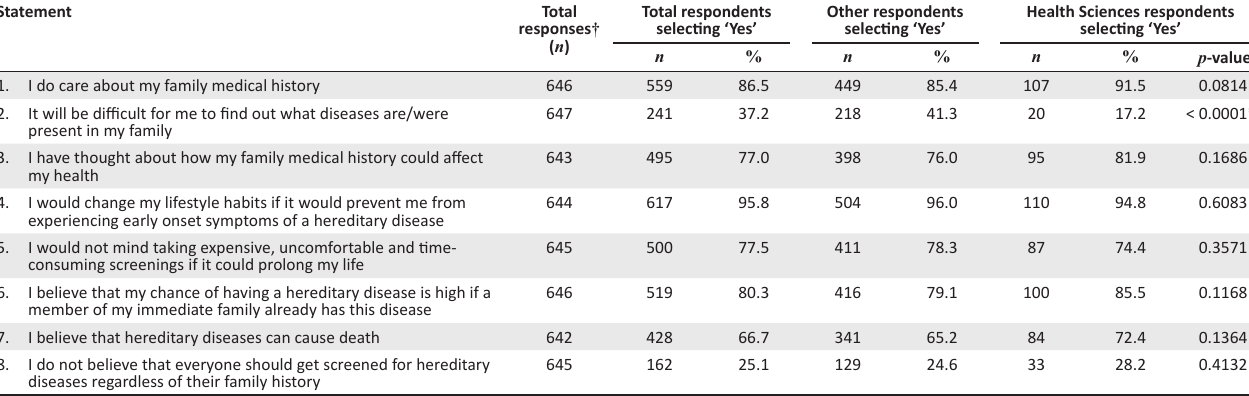
TABLE 4: Respondents’ attitudes about family medical history of hereditary diseases.